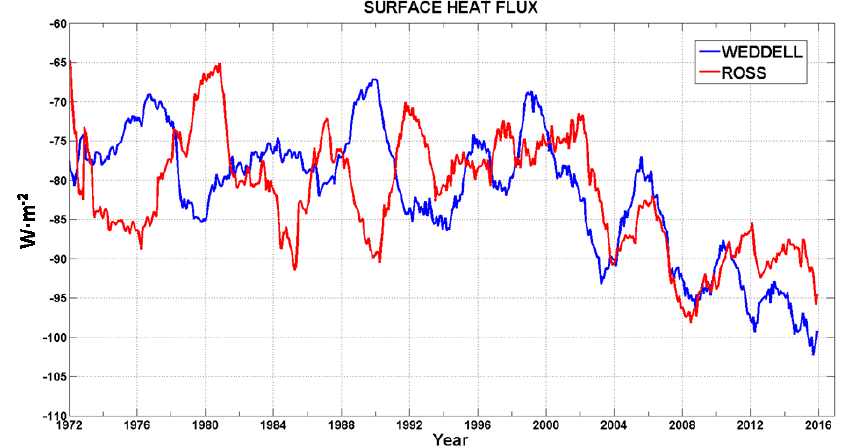
Figure 3. Surface Heat Fluxes over the Ross Sea (red) and Weddell Sea (blue) during the 1972–2015 period filtered through a twelve months running mean.